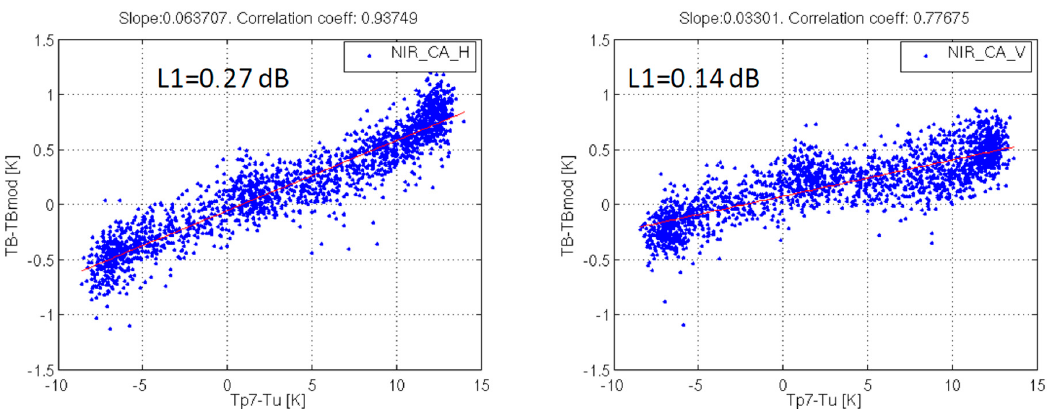
Figure 5. Variations of brightness temperature biases over the ocean as a function of temperature variations between the antenna patch and the innermost part of the antenna, for H polarisation ( left ) and V polarisation ( right